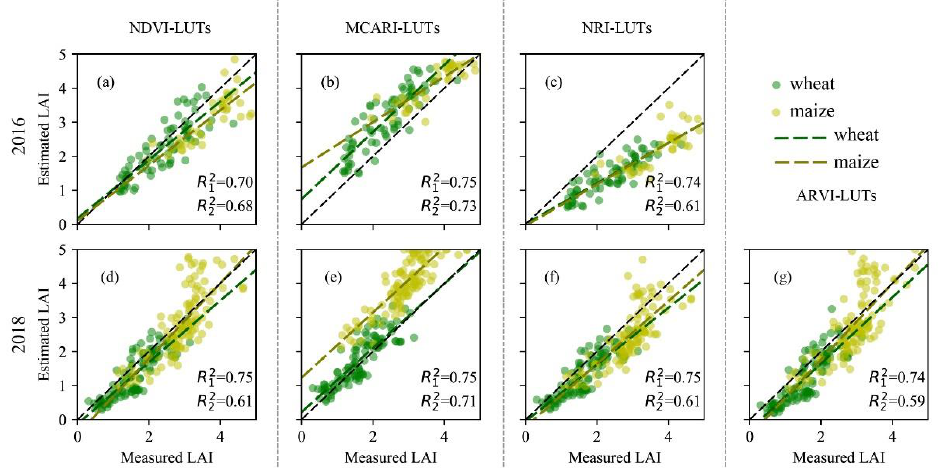
Figure A1. Comparisons of two-year measured LAI and estimated LAI values for wheat and maize based on four VIs-LUTs. ( a ) NDVI-LUT, ( b ) MCARI2-LUT, and ( c ) NRI-LUT in 2016 (multispectral data captured from multiSPEC-4C camera); ( d ) NDVI-LUT, ( e ) MCARI2-LUT, ( f ) NRI-LUT, and ( g ) ARVI-LUT in 2018 (multispectral data captured from Micasense RedEdge-M camera). R 1 2 represents the coe ffi cient of determination for a linear regression model between the measured and estimated LAI for wheat. R 2 2 represents the coe ffi cient of determination for a linear regression model between the measured and estimated LAI for maize. Table A1. R 2 , RMSE, and MRE for linear regression between simulated LAI and estimated LAI based on reflectance-LUTs/VI-LUTs using multispectral UAV data in 2016 and 2018. Reflectance-LUTs VIs-LUTs Crops Year f RMSE Input RMSE